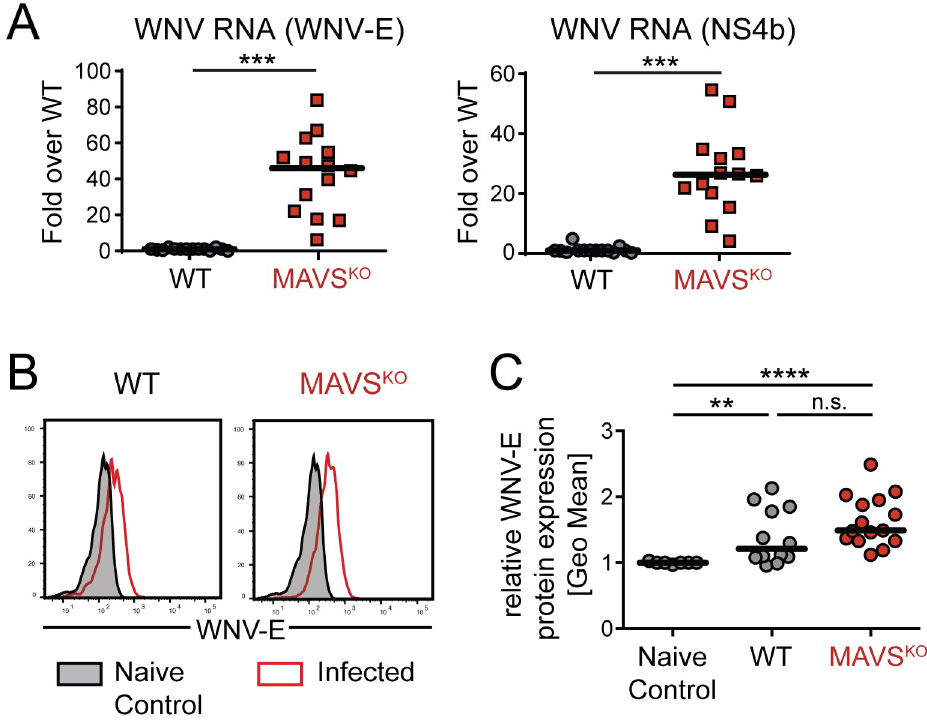
Fig 2. Similar levels of WNV-E protein in RWN-infected MAVS KO and MAVS WT mice. (A) Viral RNA levels in the dLNs on day 1 post infection with RWN (10 5 pfu/footpad) as measured by qPCR using primer pairs located in the WNV-E or NS4b genes of the viral genome. Data were normalized to the RNA level of RWN-infected MAVS WT mice. (B, C) Production of WNV-E protein in cells from the dLNs of RWN-infected MAVS KO and MAVS WT mice. Cells from the dLNs were isolated 24 hours after infection and cultured for an additional 24 hours in vitro . The amount of WNV-E protein in the combined cell lysates and supernatants was quantified by flow cytometry using an anti-WNV-E bead assay. Samples from na ï ve mice or assay buffer were used as controls. (B) A representative experiment is shown. Shaded area represents the background staining of samples from uninfected animals, red lines represent RWN- infected animals. (C) Statistical summary of geometric means of multiple independent experiments. The data were normalized to the background staining of uninfected mice in each experiment. Each dot represents one mouse; the line is the median; n.s., not significant, ��� , p < 0.0005, Mann-Whitney